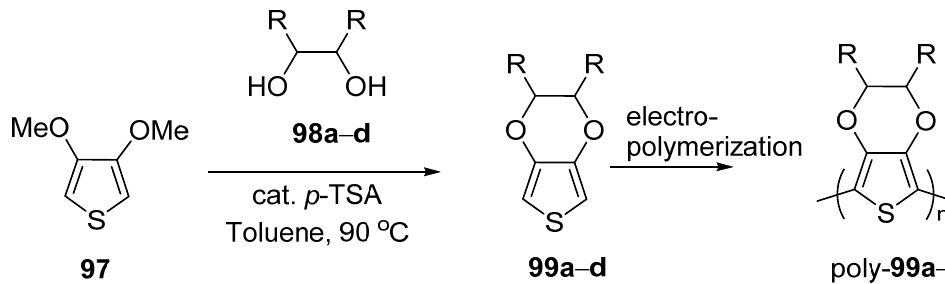
Table 1. Transetherification reaction of 3,4-dimethoxythiophene 97 and (chiral) diols 98a – d to (enantiomerically pure) disubstituted EDOTs 99a – d. Glycol Deriv. EDOT Deriv. Yield [%]